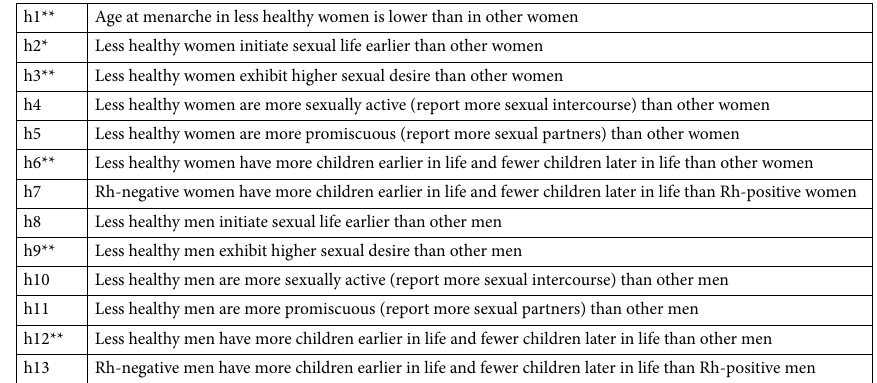
Table 1. Thirteen hypotheses tested in the confirmatory part of the study and their confirmation in GLM or path analyses. Hypotheses consistent with the results of our preregistered data analyses are marked by ‘**’; and hypothesis consistent with the results of our data analyses in the exploratory part is marked by ‘*’.